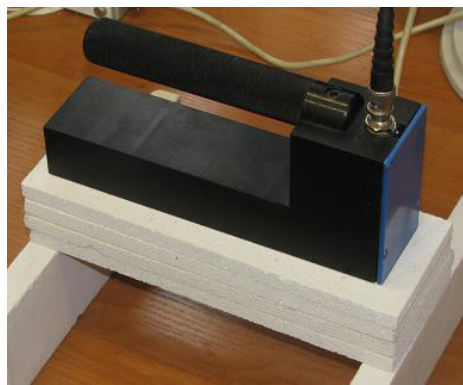
Figure 5. Sensor A during the experiment.